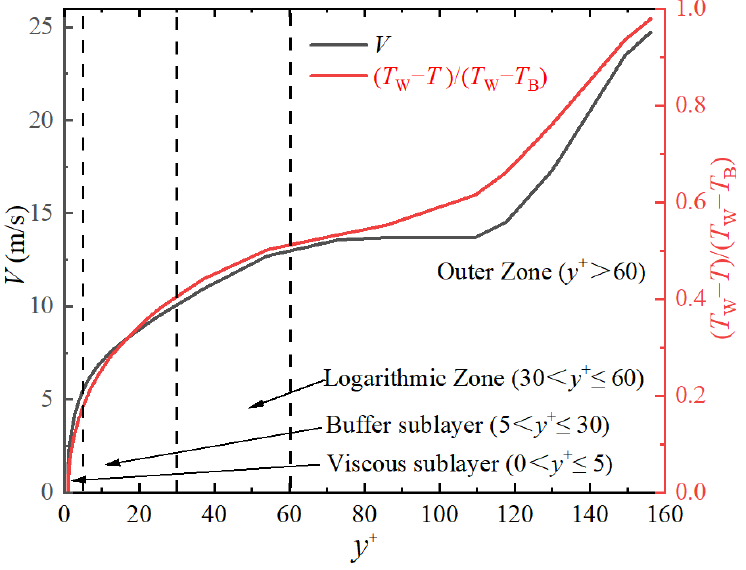
Figure 9. The radial temperature and velocity distributions under Re in = 2500 (Zig tunnel, A = tan 57.5° , q = 1 kW/m 2 , and 29% Xe).